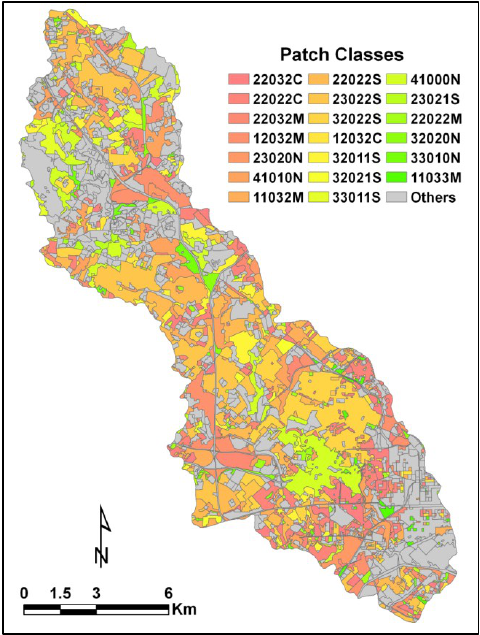
Figure 5. HERCULES patch classification for the Gwynns Falls watershed in 1999. The legend lists the first 20 dominant classes, which accounted for 43.8% of all the patches.